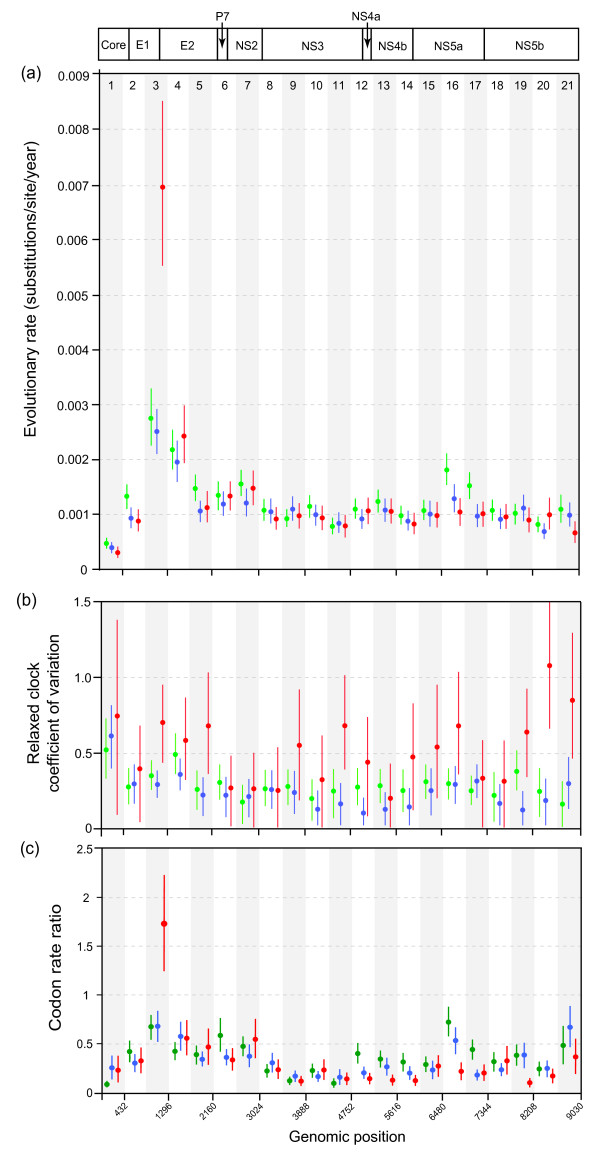
The molecular clock behaviour of the HCV genome. Three separate data sets are shown: among host subtype 1a (green), among host subtype 1b (blue) and within-host (red). Separate parameters were estimated for each of 21 partitions spanning the HCV coding region (see genome schematic and partition numbering at top of Figure). The alternating white and grey bars are for visual clarity only; nucleotide numbering according to the H77 reference genome is show at the bottom. (a) Estimated mean evolutionary rates. For each partition and data set, the vertical bar represents the range of the 95% HPD credible region and the circle represents the point estimate of the mean rate. (b) Estimated coefficient of variation (COV) parameters for each partition and data set, which represent the among-lineage rate heterogeneity. The vertical bars represent the range of the HPD credible region and the circle shows the estimated COV value. (c) Estimated codon rate ratio (CRR) values, which represent the ratio of the evolution rate at codon positions 1 and 2 to that at codon position 3. As before, the vertical bar represents the range of the 95% HPD credible region and the circle represents the point estimate of CRR.